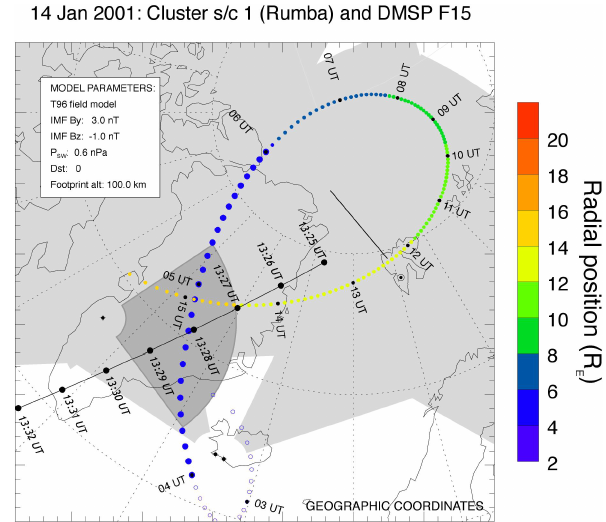
Fig. 2. Ionospheric projection of the Cluster and DMSP F15 or- bit on 14 January 2001. Momentary locations are indicated every 30min for Cluster and every minute after 13:25 UT for DMSP F15. The altitude of Cluster is given by a colour scale. Also marked are the field-of-views of some SuperDARN radar facilities, the range of the ESR northward pointing radar beam, and the scan coverage of the STF IS-radar. The coordinate grid is